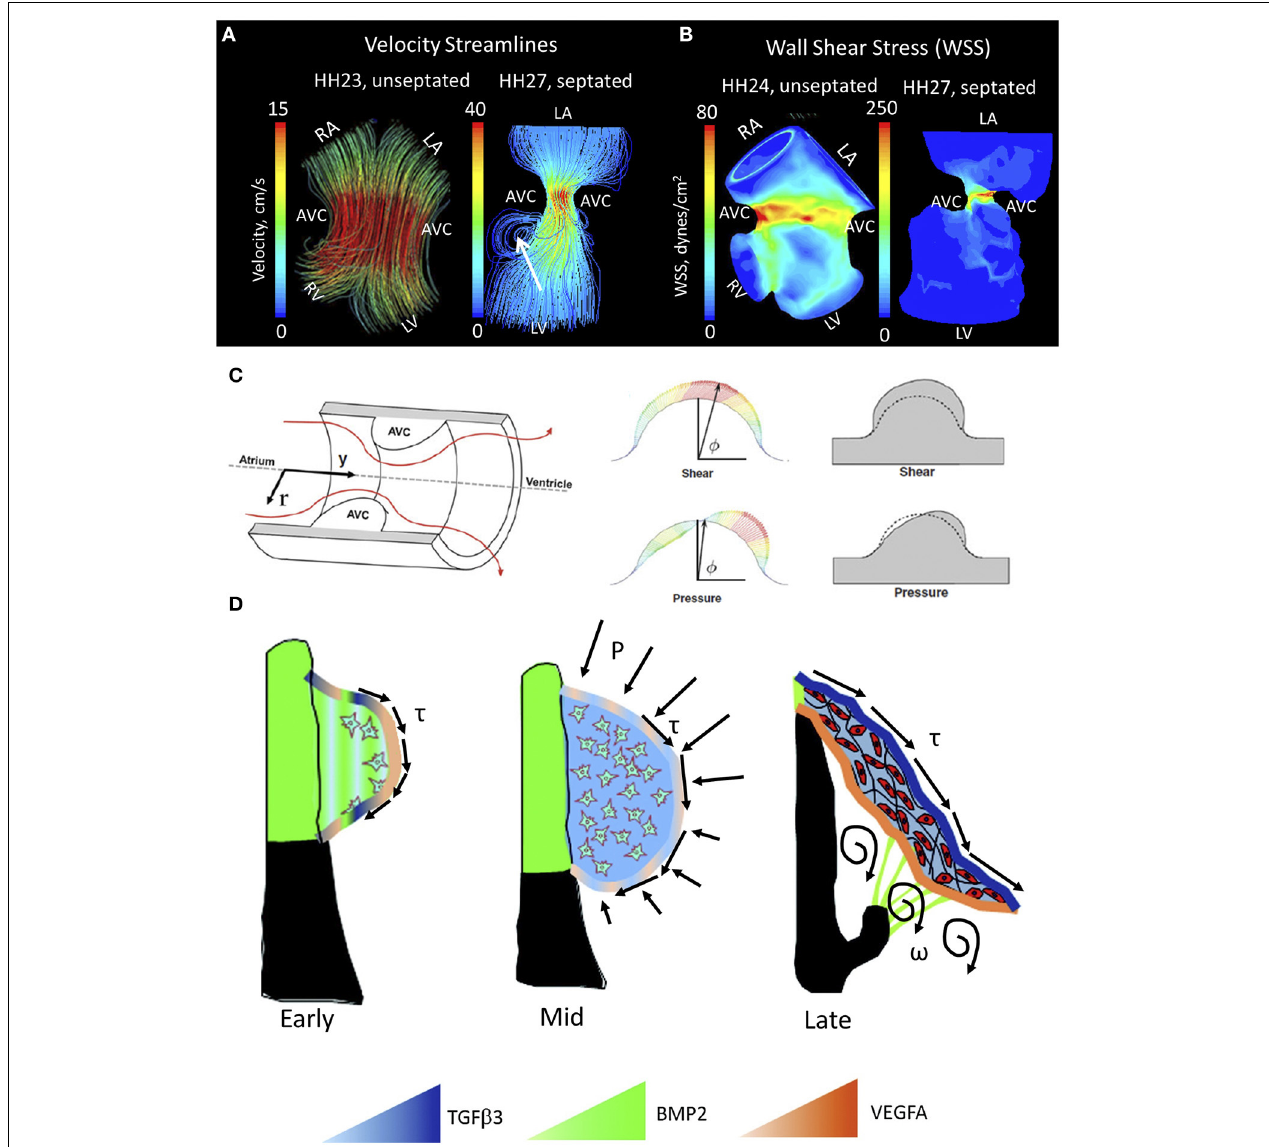
FIGURE 4 | Mechanical forces driving AV valve morphogenesis. (A) Velocity streamlines in AV canal for HH23 (unseptated) and for HH27 (septated) chicken embryos, generated with computational fluid dynamics. In HH23, flow profile is laminar parallel streamlines, whereas in HH27 it is jet flow with circulating eddies beneath AV cushions (shown with arrrow). LA, left atria; RA, right atria; LV, left ventricle; RV, right ventricle; AVC, atrioventricular cushion (B) WSS levels for HH23 and HH27 embryos. High stress levels are localized to the mid cushion region. Adapted form Yalcin et al. (2011). (C) Hemodynamic-driven AV cushion growth and remodeling computational model. Based on this model, the pressure distribution on the